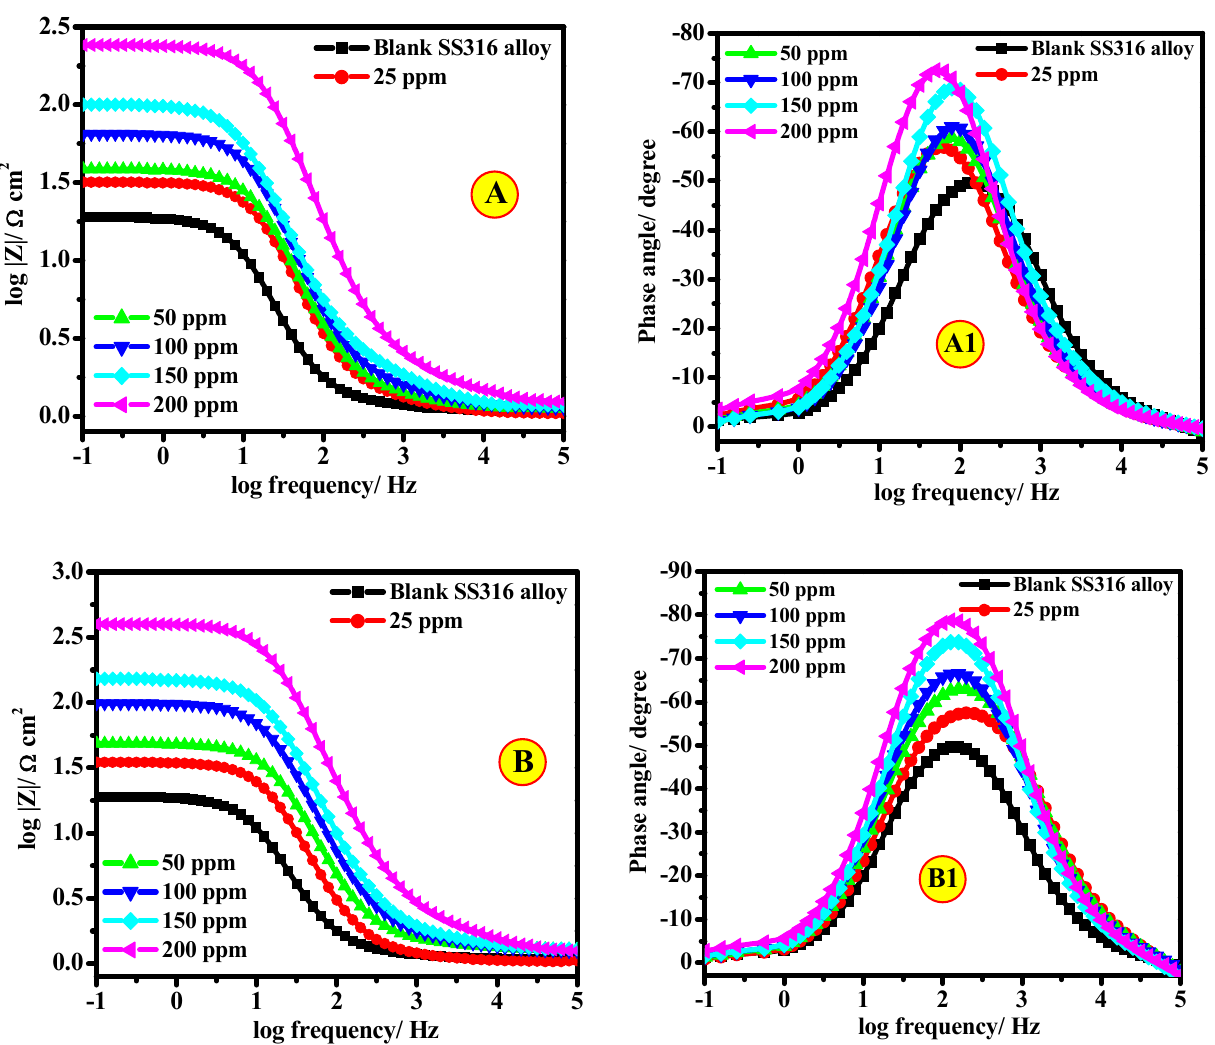
Figure 9. Bode ( A , B ) and Bode phase ( A1 , B1 ) diagrams of SS316 alloy in 2.0 M HCl in the absence and the presence of various concentrations of ( A ) CEL and ( B ) NCC, at T = 323 K.